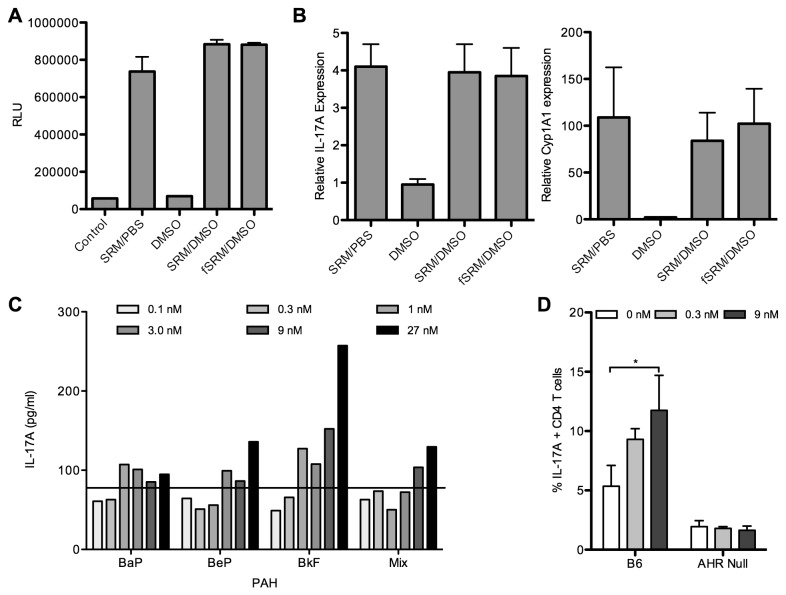
Investigation of the specific components of SRM1649b that contain Th17 enhancing activity.A: Mouse Hepa1 cells that were transfected with luciferase reporter gene fused to the dioxin-responsive elements (DRE) were seeded at 0.6x106 cells per well. Cells were then exposed to media (Control), media + SRM1649b suspended in PBS (SRM/PBS), media + DMSO (DMSO), media + SRM1649b suspended in DMSO (SRM/DMSO) or the organic fraction of SRM1649b suspended in DMSO (fSRM/DMSO) for 4 hours. Luciferase activity was measured on a luminometer. B: Naïve B6 CD4+ T cells in Th17 conditions in the presence of fractioned SRM1649b and controls. After 4 days, total RNA was harvested. Using qRT-PCR, the relative levels of IL-17A and Cyp1a1 mRNA were determined. Data presented are the mean and standard deviation of 2 separate experiments and is relative to cells treated with anti-CD3/CD28 antibody stimulation but without mIL-6 and huTGF-β. C: Naïve B6 CD4+ T cells in Th17 conditions in the presence varying concentrations of the PAHs benzo[a]pyrene (BaP), benzo[e]pyrene (BeP) and benzo[k]fluoranthene (BkF). Culture supernatant was harvested and ELISA measured the concentration of IL-17A. The line indicates the level of IL-17A expression in cultures exposed to DMSO vehicle only. D: Naïve B6 or AHR-/- CD4+ T cells in Th17 conditions in the presence of BkF. Cells were harvested and subjected to intracellular cytokine analysis to determine the percent of IL-17A-expressing CD4+ T cells present after culture. Data from 3 separate experiments was pooled and statistical comparison was made between the cultures with versus cultures without BkF.